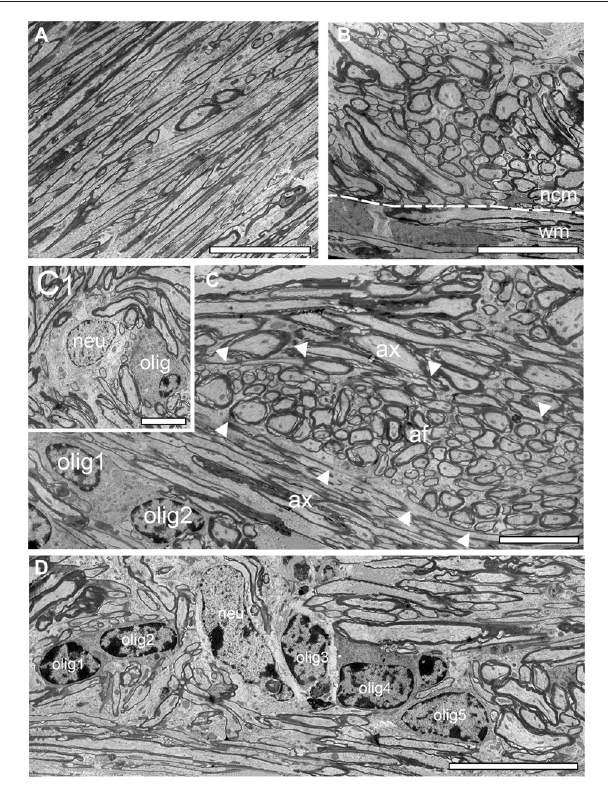
FIGURE 3 | Structural organization of the white matter reeler . (A) High power EM micrograph of parallel running axonal bundles in the deep white matter. Scale bar 50 µ m. (B) Transition zone between the white matter (wm) and the neocortical mass (ncm; dashed line) with emerging putative ascending thalamocortical axons traversing the neocortical mass. Note the change in the orientation of the myelinated axons. Scale bar 50 µ m. (C) Fasciculated axonal fibers (af, marked by arrowheads) between parallel oriented white matter axons (ax) with two oligodendrocytes (olig1, olig 2). Scale bar 25 µ m. (C1) Within such fascicles white matter neurons (neu) and oligodendrocytes (olig) were sometimes observed. Scale bar 10 µ m. (D) Five oligodendrocytes (olig 1–5) building a heterologous cluster with a neuron (neu) in deep white matter. Scale bar 20 µ